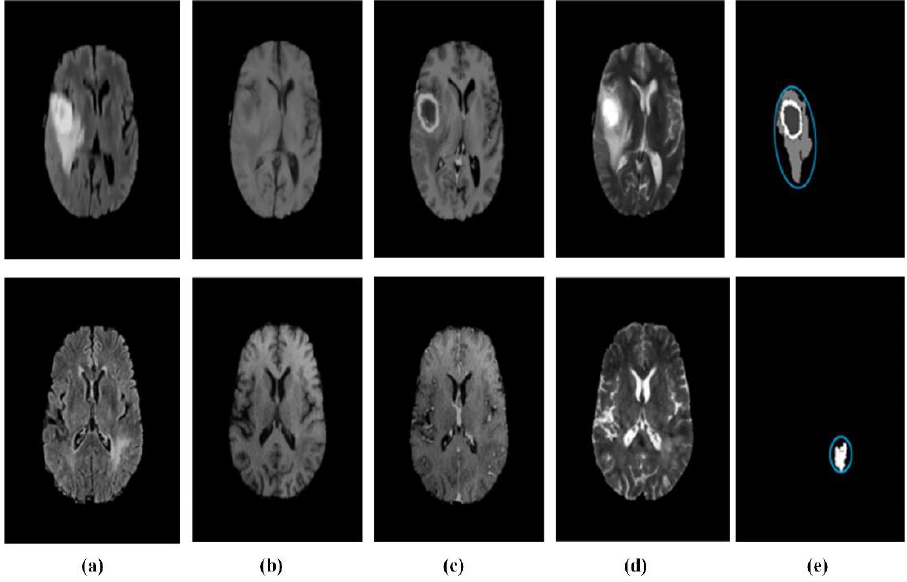
Figure 20. Brain tumor segmentations by multi-network. ( a ) Flair. ( b ) T1. ( c ) T1c. ( d ) T2. ( e ) Segmen- tation results. Copyright 2018 Elsevier. Table 4. Evaluation results of MRI brain tumor segmentation based on single CNN network.